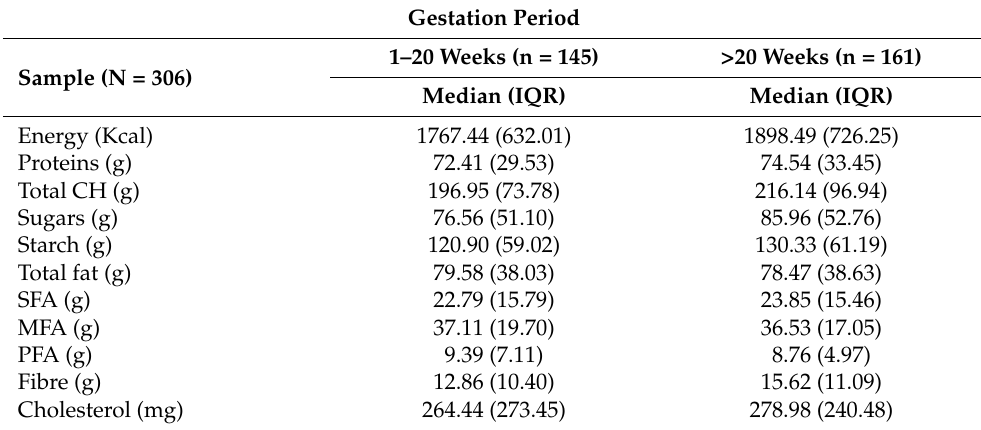
Table 2. Energy, macronutrients, fiber, and cholesterol according to the gestational period (median and interquartile